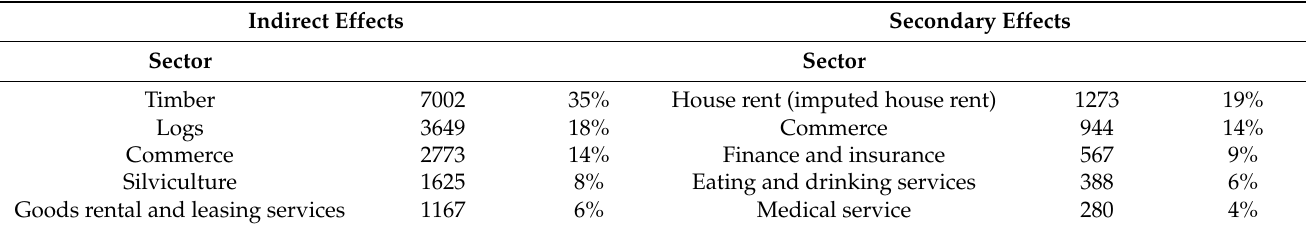
Table 6. Indirect and secondary effects (in thousands of yen) of the construction of a timber dam, with percent contribution to production value induced: top five sectors.